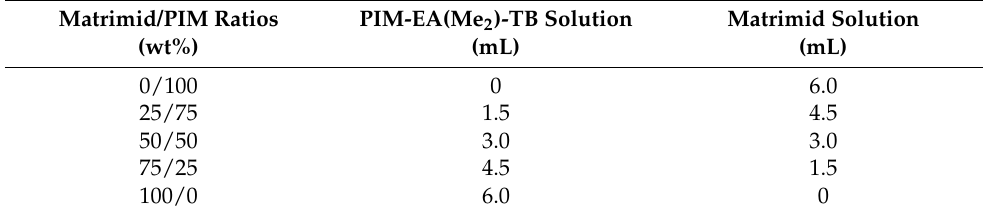
Table 2. Solutions of PIM-EA-(Me2)-TB and Matrimid ® 5218.